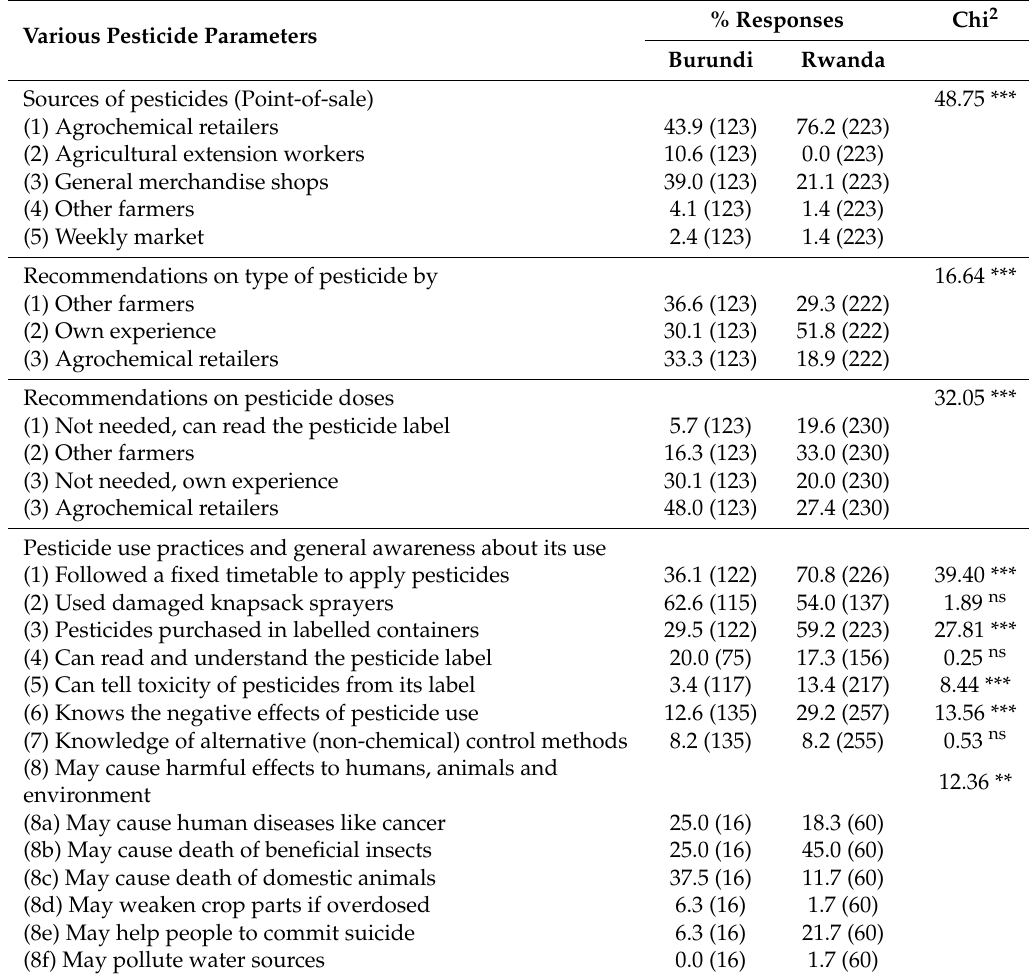
Table 4. Sources of information for farmers of RTB crops regarding the use of pesticides and general awareness and pesticide use practices in Rwanda and Burundi (total number of respondents in